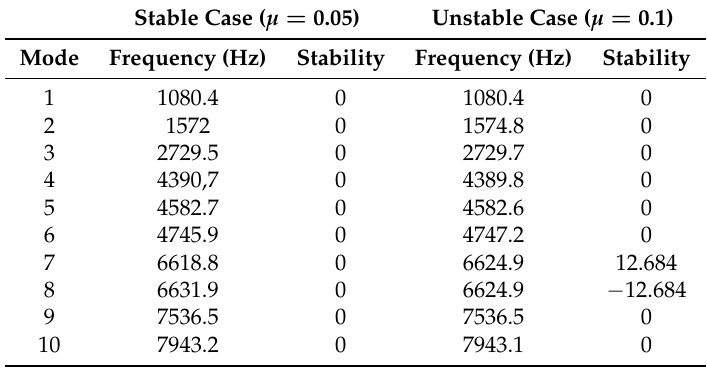
Table 2. First 10 modes for the two cases of study